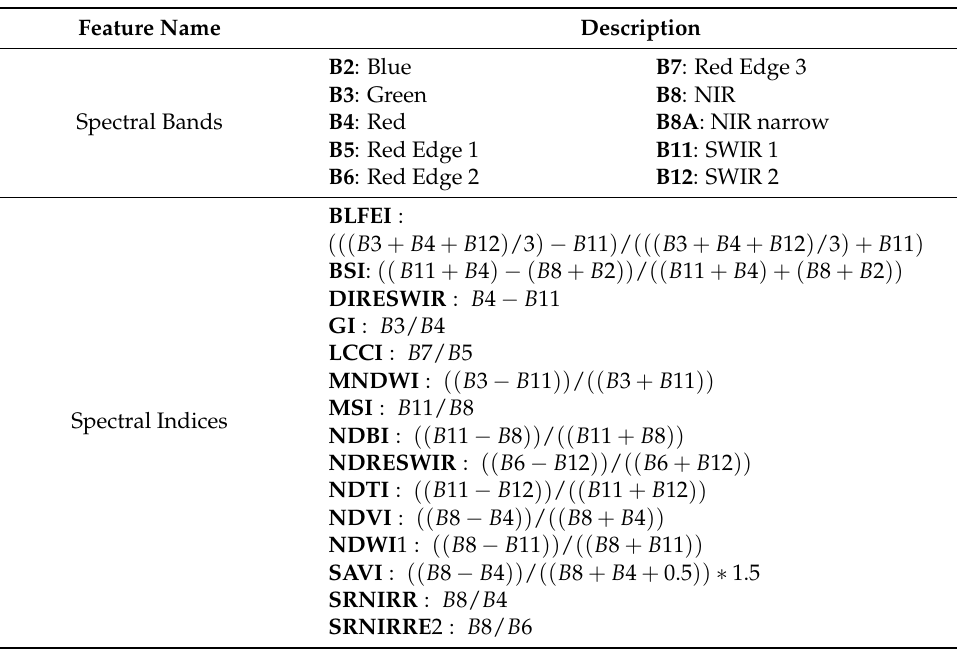
Table 2. Spectral bands and indices extracted from S2 and used for LULC